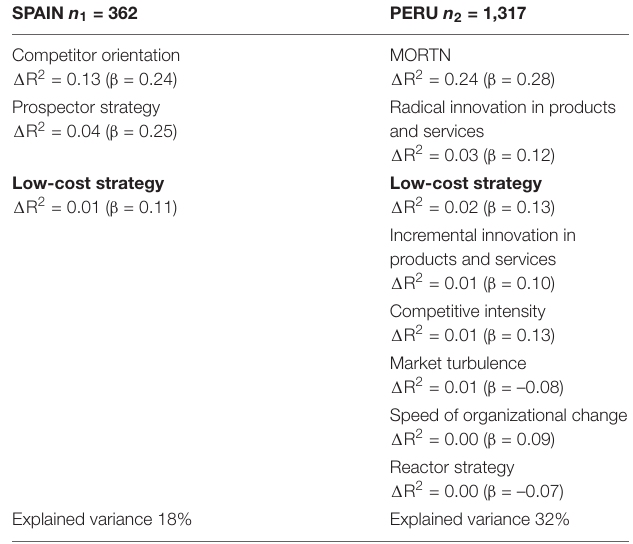
TABLE 9 | Summary of the predictive variables for the Market culture, sorted by the value of the R Change, from highest to lowest.